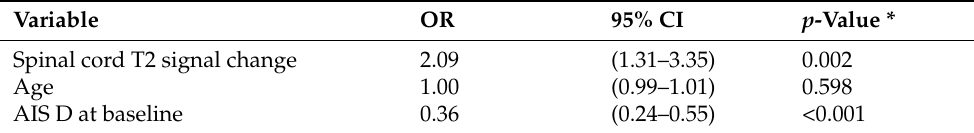
Table 4. Logistic regression model for adverse events in spinal cord injury patients ( n =